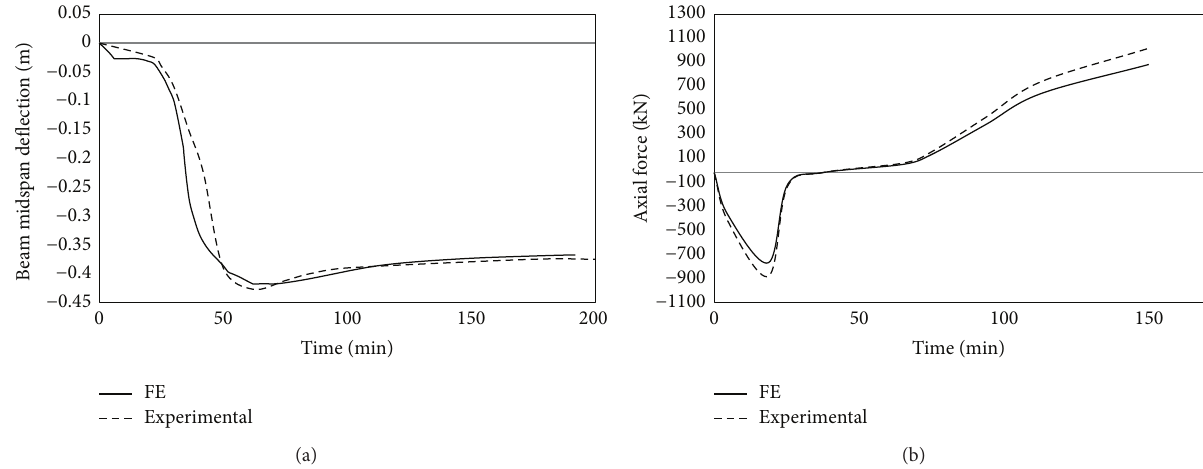
Figure 7: The validation of numerical models with experimental results: (a) shift of the center of the beam; (b) axial force on the screw.